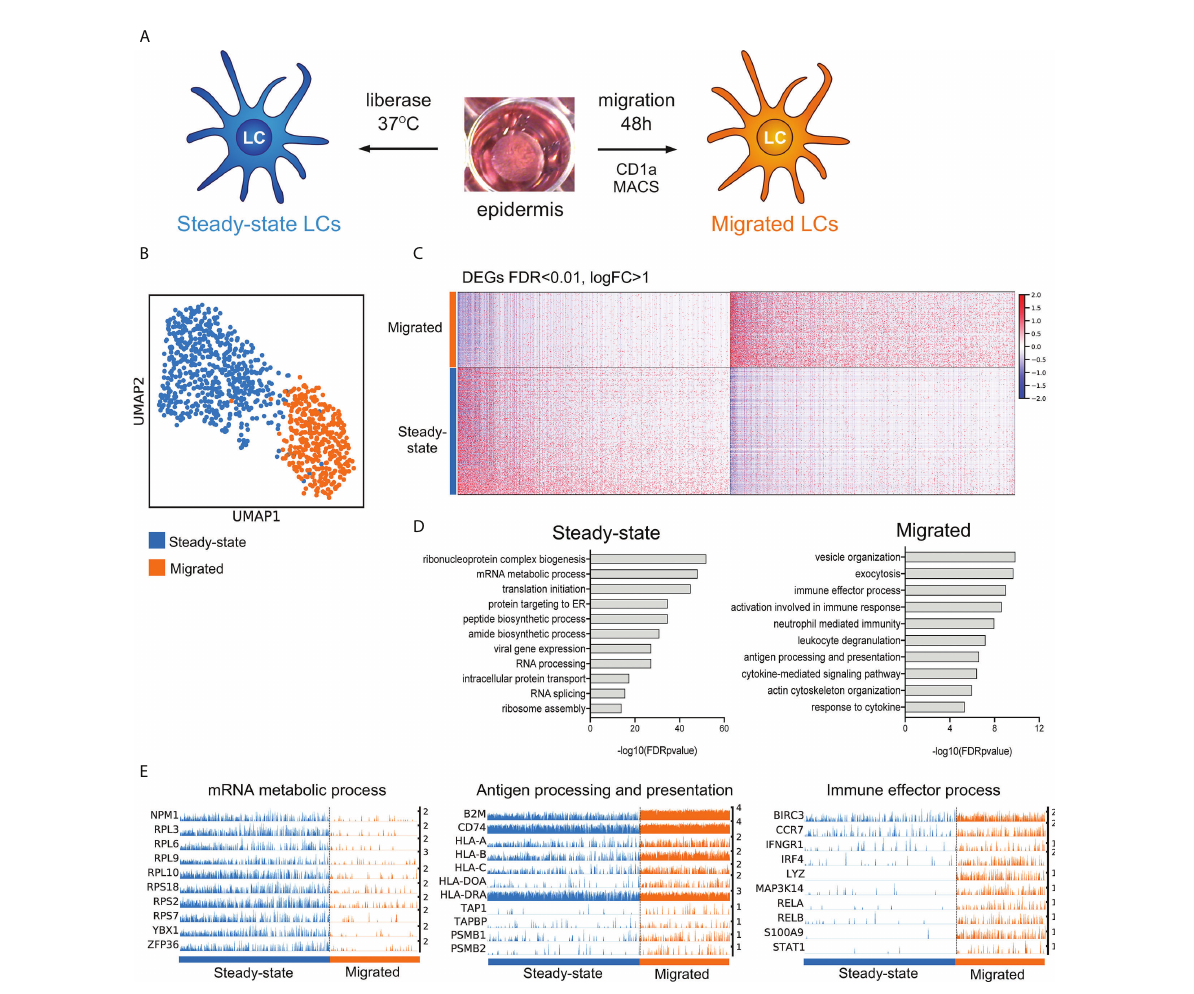
FIGURE 1 LC migration from the epidermis induces immunocompetence associated transcriptional modules. (A) A schematic illustrating isolation of primary human LCs. Split healthy skin was treated with dispase for 20h to dissociate epidermis. Steady-state LCs were isolated from the epidermis by digestion with liberase TM or migrated from the epidermal sheets for 48h in cell culture medium (B) UMAP dimensionality reduction analysis of Scran normalised single cell data from steady-state (585) and migrated (387) LCs originating from the same donor. (C) Heatmap displaying the 1002 upregulated DEGs in steady-state LC and 1012 DEGs upregulated in migrated LC (FDR corrected p=<0.01, logFC>1). (D) Gene ontology analysis (Toppgene) results are displayed alongside for steady-state and migrated LC upregulated DEGs (-log10 FDR corrected p-values) (E) Trackplots displaying genes included in ontologies upregulated in steady-state (mRNA metabolic process) and migrated LC (antigen processing and presentation, immune effector